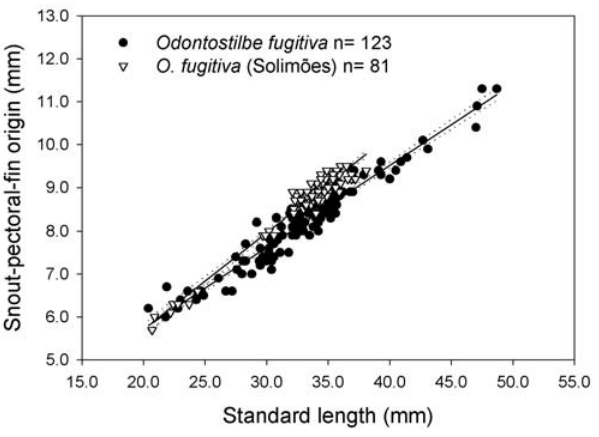
Fig. 12. . Snout to pectoral-fin length as a function of stan- dard length for males, females, and unsexed specimens of Odontostilbe fugitiva , specimens widely distributed in rio Amazonas basin against specimens of rio Solimões basin (middle rio Amazonas).